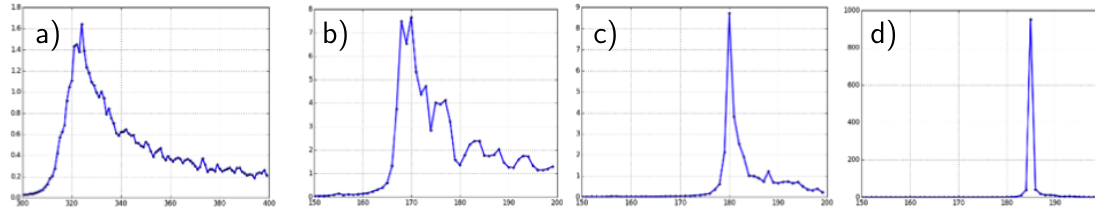
Figure 40. Examples of SAR mode waveforms for 4 surface types: ( a ) open ocean, ( b ) thick pack ice, ( c ) thin pack ice and ( d ) ripple-free water within a lead in the ice. The waveforms differ both in shape and in backscattered power, which in these examples range by a factor of 1000.